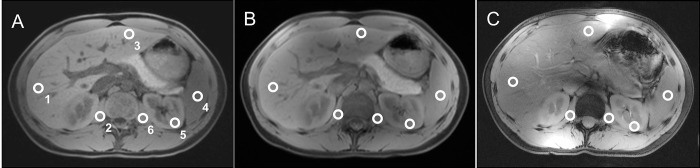
2D FLASH.2D FLASH imaging at 1.5 Tesla (A), 3 Tesla (B) and 7 Tesla (C) in the same subject. The white circles indicate the ROIs for signal measurements in the right liver lobe (1), right psoas muscle (2), left liver lobe (3), spleen (4), left kidney cortex (5) and left psoas muscle (6). Note the slight motion artifacts due to breathing as well as the slight loss in contrast at 3 Tesla (B) compared to 1.5 Tesla (A) and the hyperintense delineation of intra-abdominal vasculature at 7 Tesla (C).